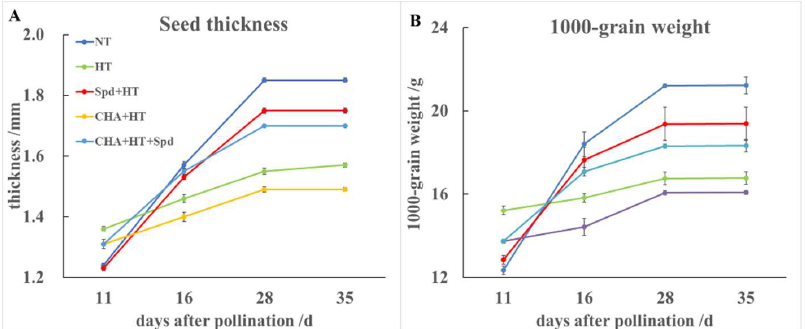
Figure 2. Effects of exogenous Spd and CHA on ( A ) the thickness and ( B ) the 1000-grain weight of rice seeds at different developmental stages under high-temperature stress. The treatment methods were the same as those in the Figure 1 notes.